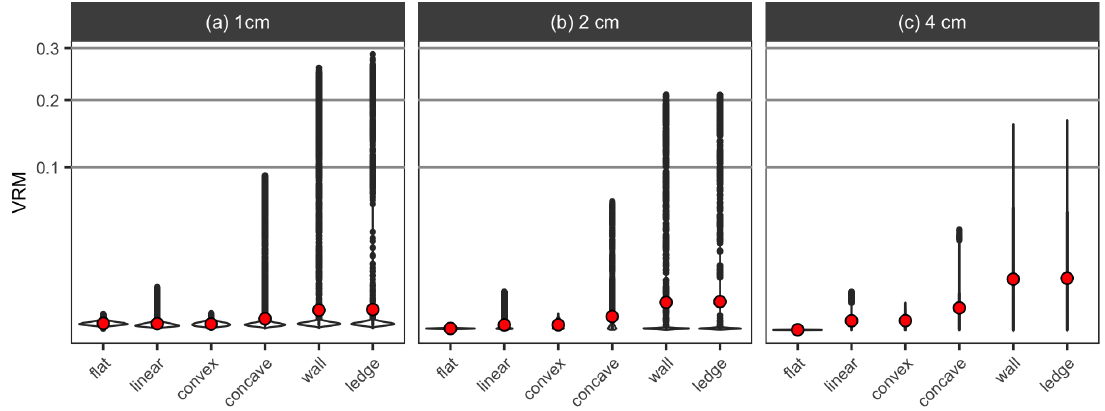
Figure 8. Violin plots for VRM extracted at three different resolutions, ( a ) 1 cm, ( b ) 2 cm and ( c ) 4 cm, from the DEMs of the six simulated surface structures. The mean value of VRM for each surface structure is shown as red points.